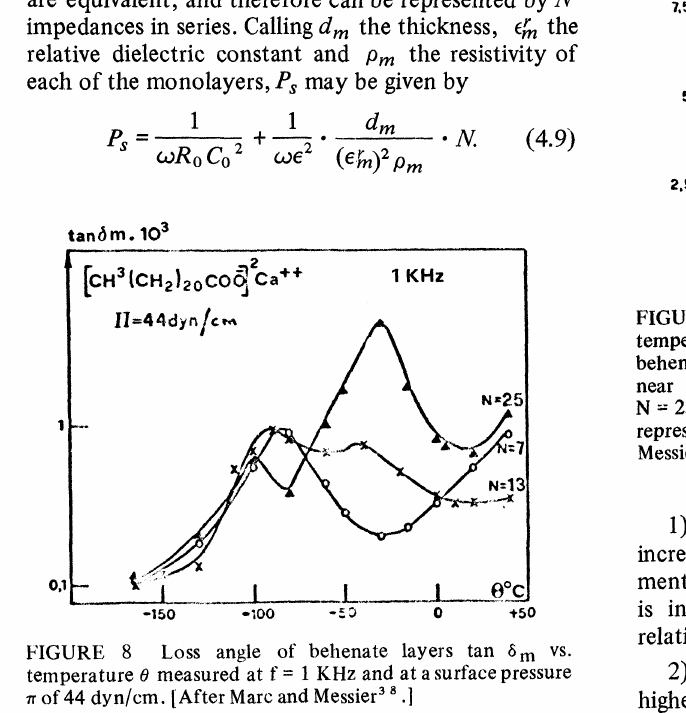
Comparison of dielectric losses with respect to temperature (a) corresponding to a point in the middle of the behenate film, well organized structure, and (b)at a point near the edge, disorganized structure. Data reported for N "---25, r =44 dyn/cm and f= KHz. The lowest curve represents losses due to oxide layer. [After Marc and Messier 38